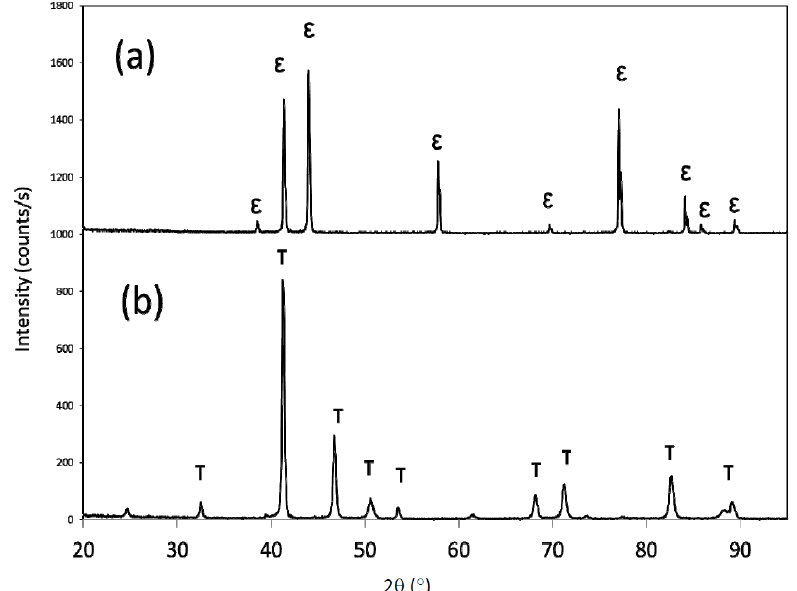
Figure 1. X-ray diffraction patterns for ( a ) as-spun Mn treatment at 500 °C for 10 min.